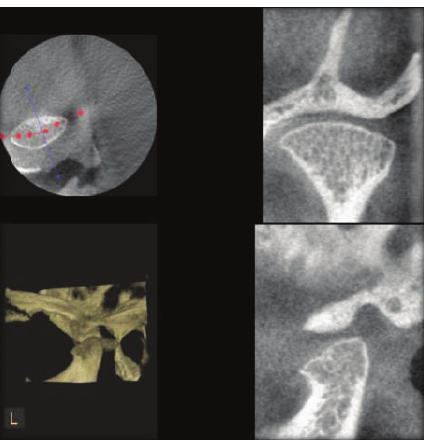
Figure 3: Normal condyle as seen in DVT.